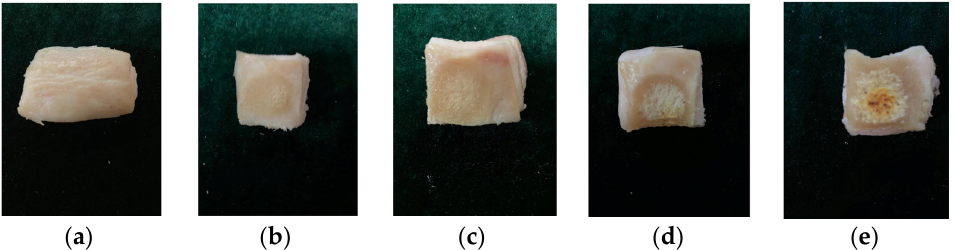
Figure 17. Burns of different degrees: ( a ) burned for 0 s; ( b ) burned for 40 s; ( c ) burned for 80 s; ( d ) burned for 120 s; ( e ) burned for 160 s.